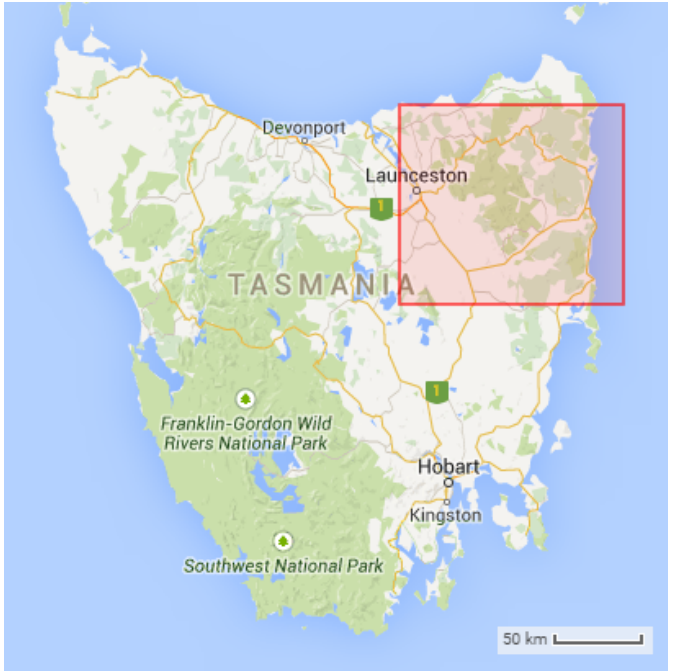
Figure 1. Location of South Esk Hydrological model, northeast of Tasmania, Australia. The exact coordinate locations of the red bounded region are: 42 ◦ 00 (cid:48) S, 147 ◦ 00 (cid:48) E (bottom, left) and 41 ◦ 00 (cid:48) S, 148 ◦ 30 (cid:48) E (top, right), which covers approximately 18,588 km 2 (image adapted from Google